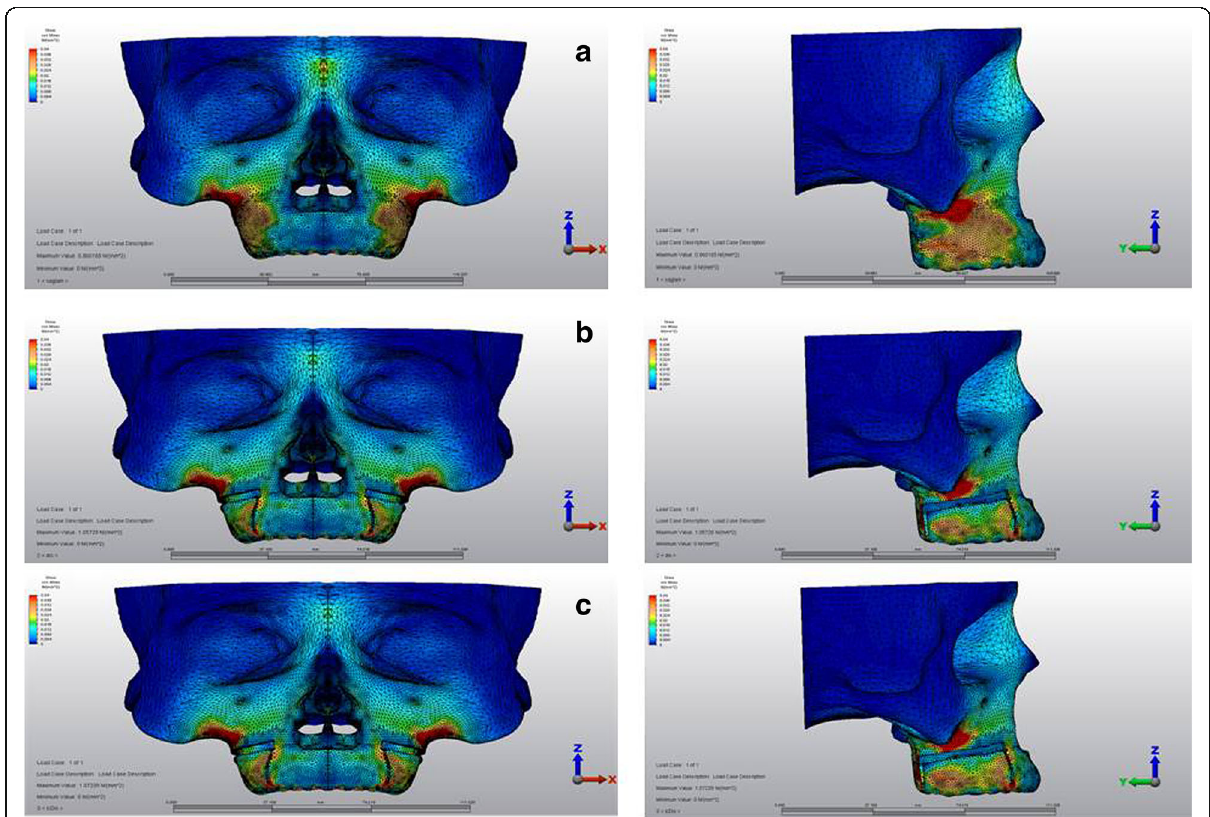
Fig. 3 Stress distributions over cortical bone a first, b second, and c third